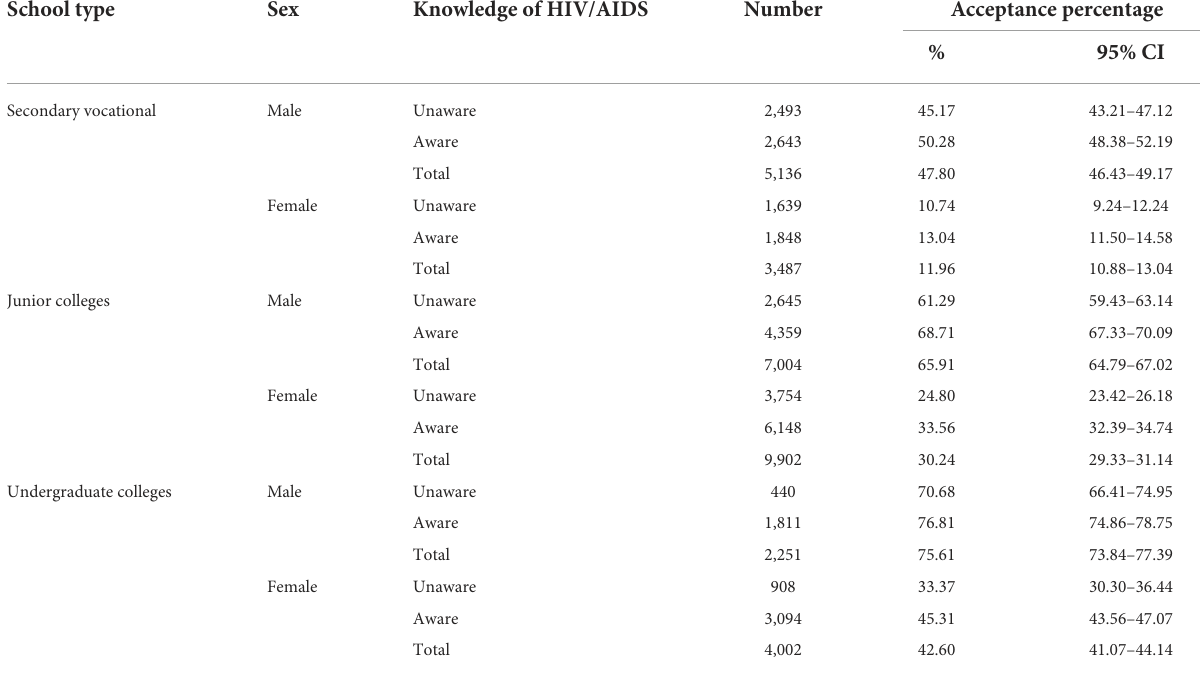
TABLE 6 Young students’ attitudes toward premarital sexual behavior ( n =